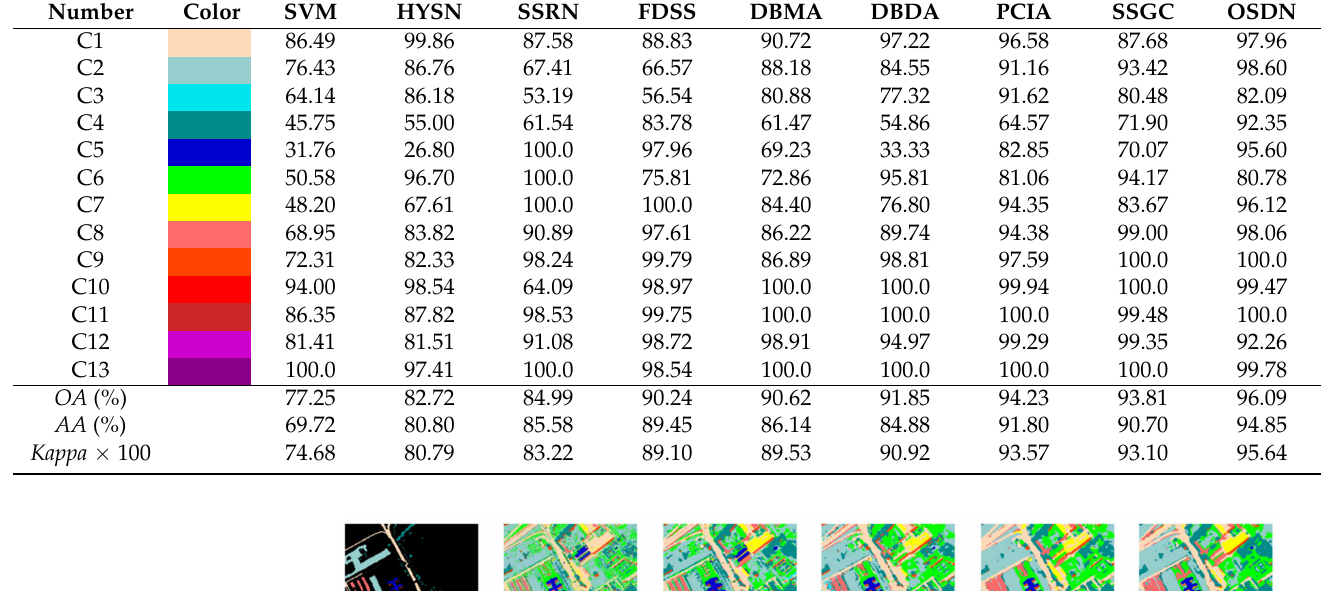
Table 12. Classification results of the KSC dataset based on 2% training samples.